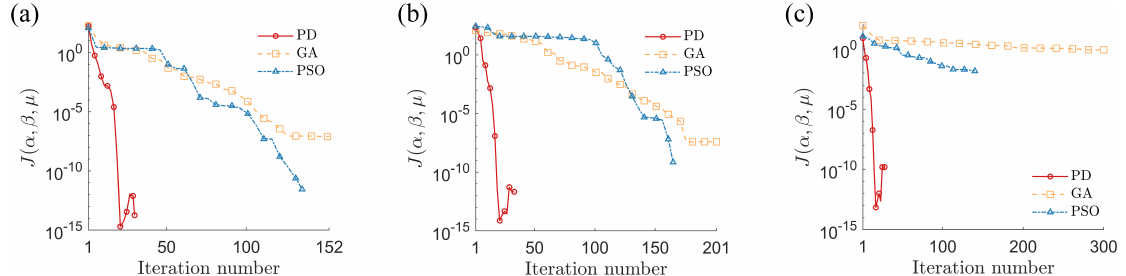
Figure 3. Error convergence of objective function J ( α , β , µ ) during parameter identification for three van der Pol–Duffing oscillators: ( a ) single-well, ( b ) double-well, and ( c ) double-hump.